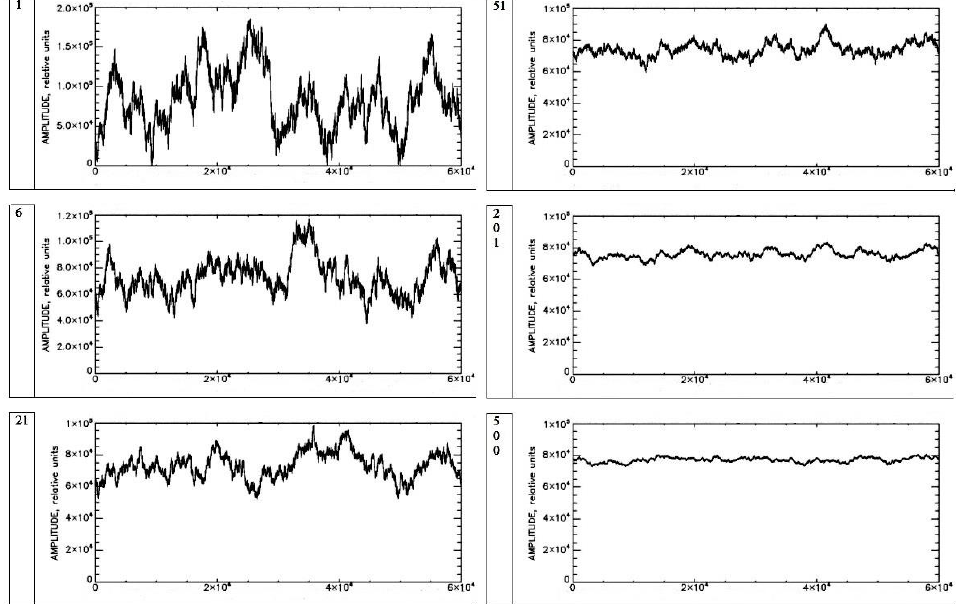
Figure 2. Average envelopes of the simulated return signal at ξ d = 0.1 after averaging a given number (labeled in the left column) of consecutive single realizations in session 10. The distance is indicated along the abscissa axis (in slice numbers).